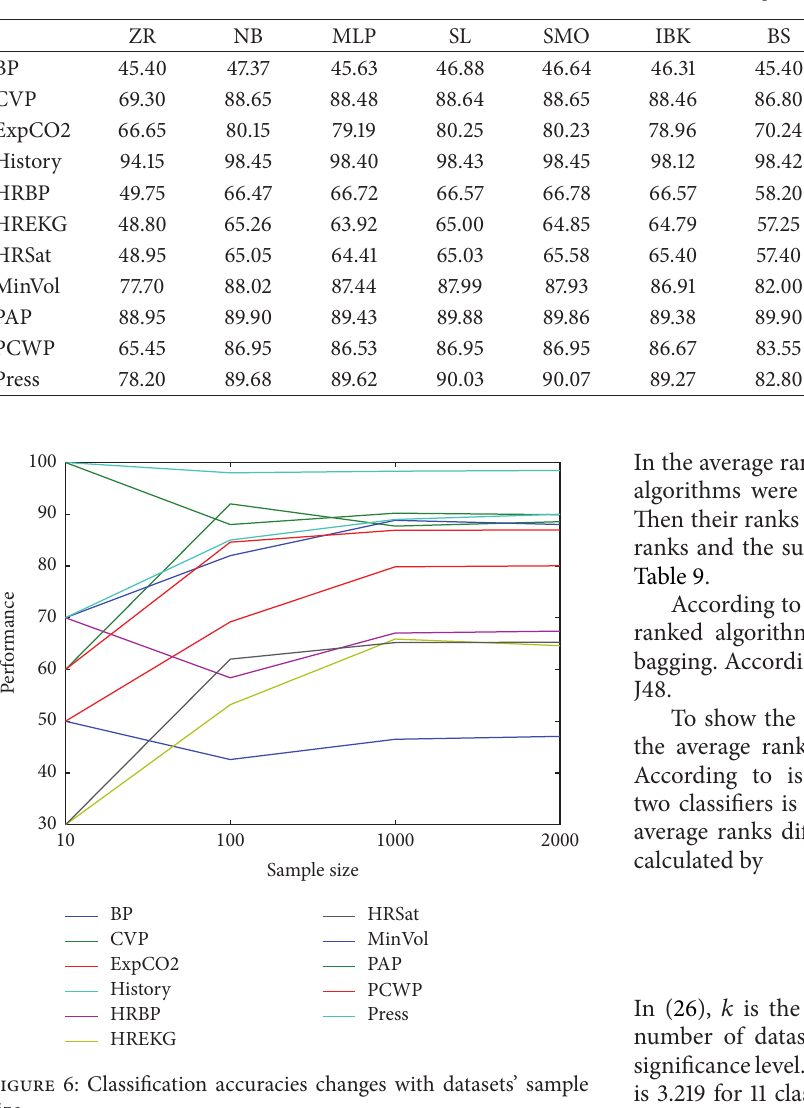
Table 7: Classification accuracies with datasets having 2000 samples (%).